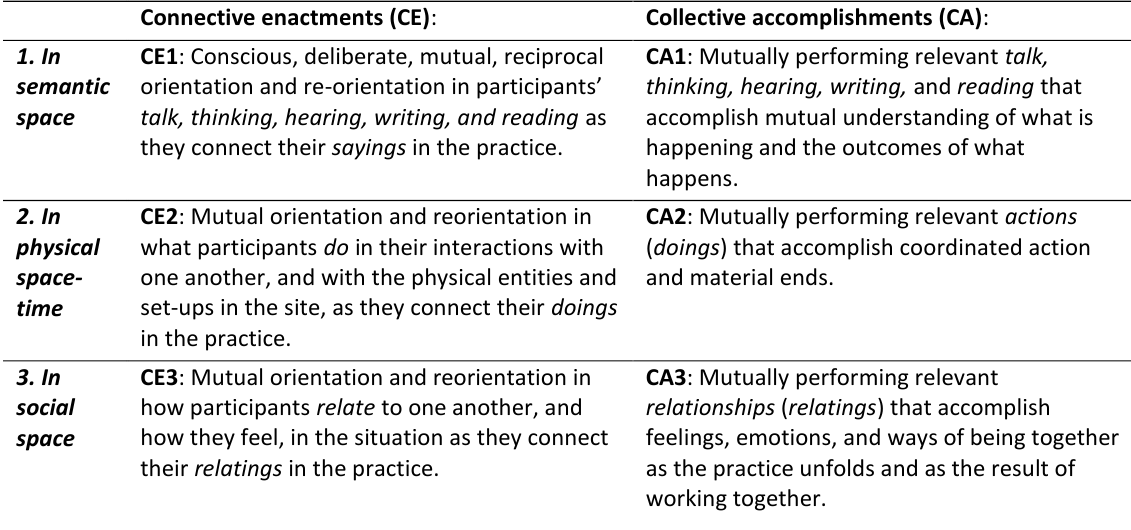
Table 1. Three faces of connective enactment and collective